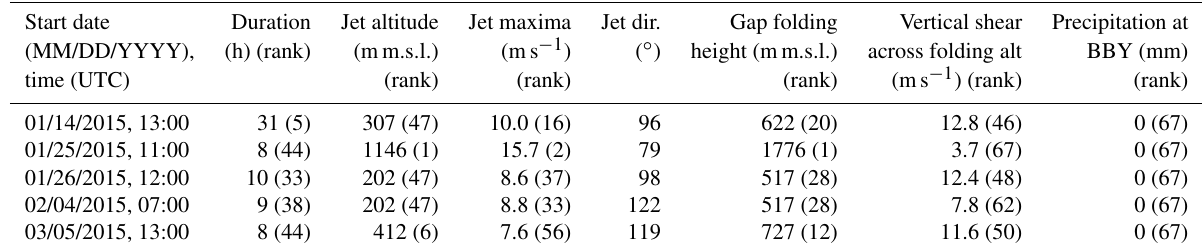
Table 3. PGF events observed during CalWater 2015 and their significant parameters following N06. Ranks are out of 67 (62 cases from N06 plus 5 from CalWater